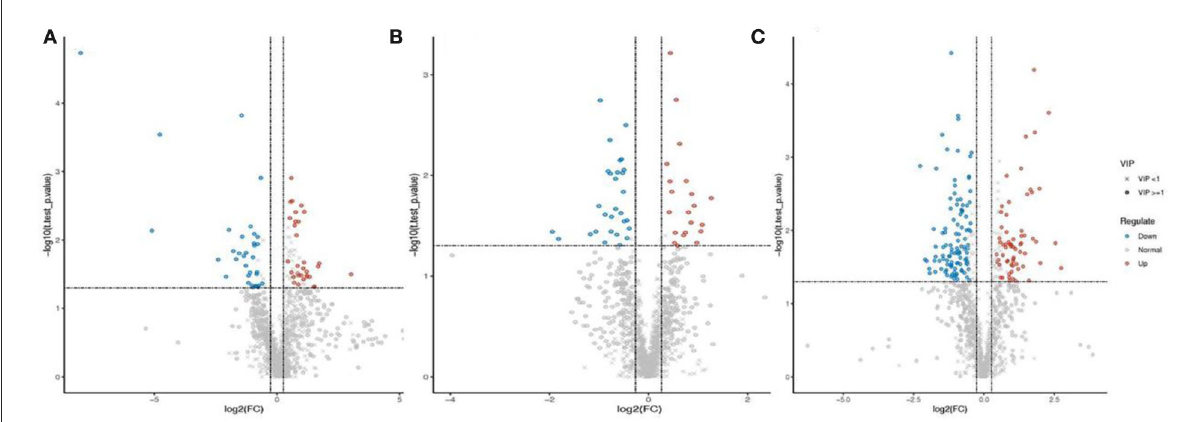
FIGURE6 Differential metabolites between E + barley and E– barley under salt stress conditions. Volcano plot of differential metabolites. Volcano plot of differential metabolites in barley samples for LC-MS data (A–C) . The volcano plot was used to visually display the selected differential ions. Blue dots are the downregulated significantly differential ions, the red dots are the upregulated significantly differential ions, the circles are the ions with VIP ≥ 1, the “ × ” represents ions with VIP < 1, and the insignificant ions are marked gray. The measurement data are shown in Supplementary Tables S4–S6.